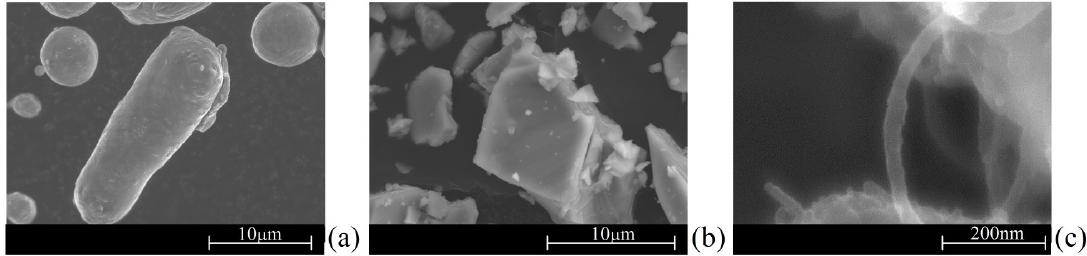
Figure 8. SEM micrographs of the starting raw materials: ( a ) Al ‐ 12 alloy; ( b ) TiH 2 powder; ( c ) multiwall carbon nanotubes (MWCNTS) ‐ COOH.